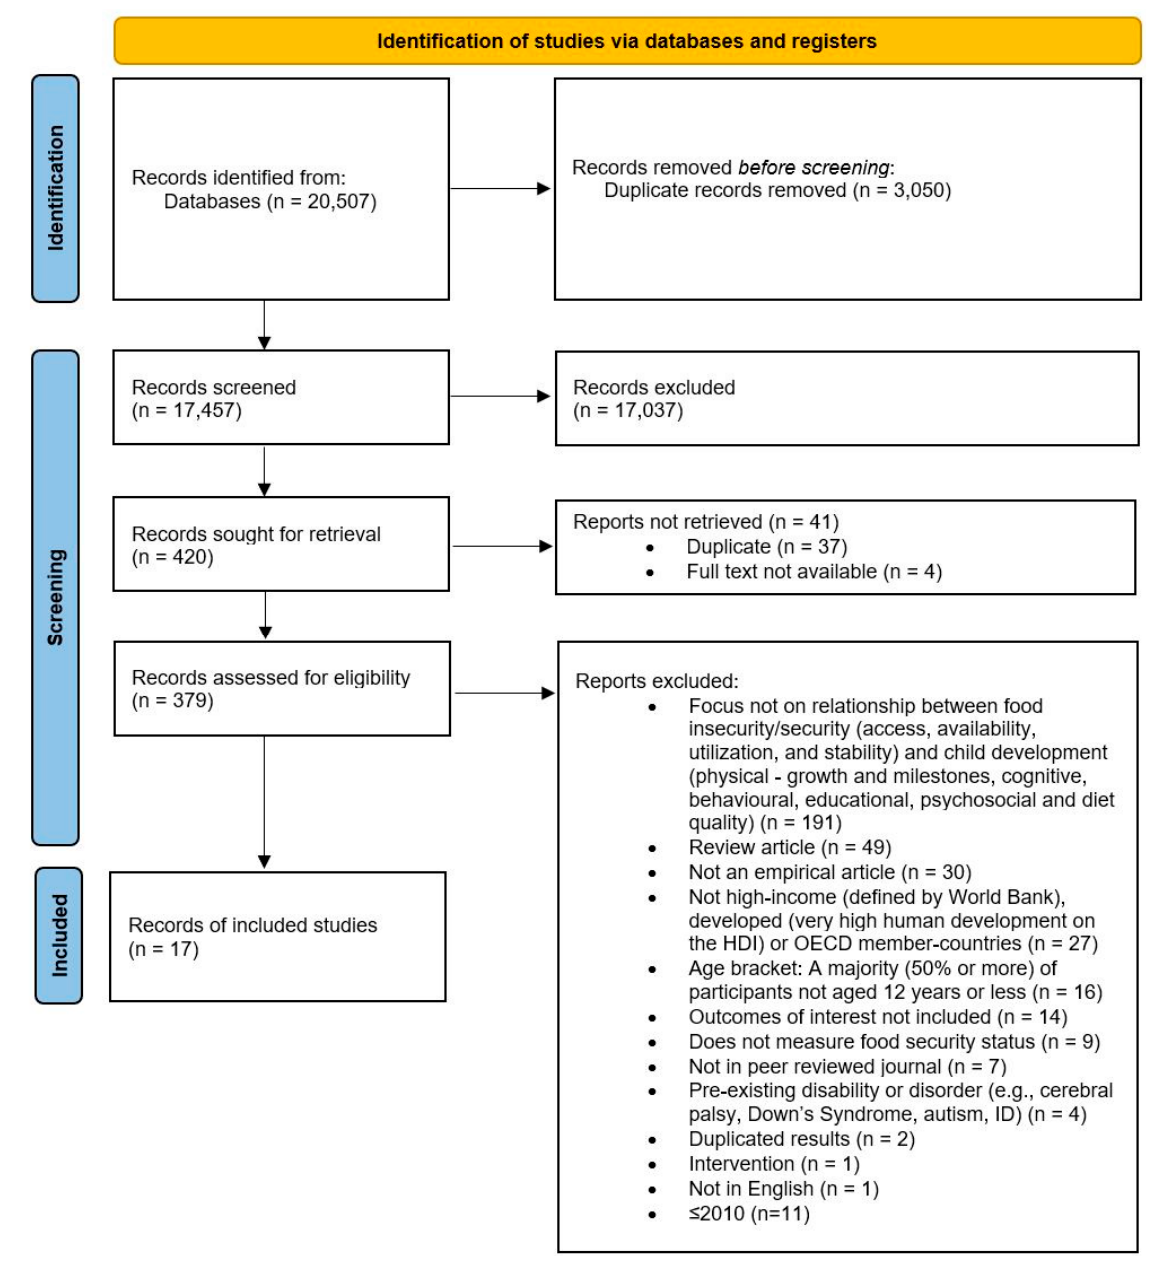
Figure 1. PRISMA diagram of search, adapted from [20].